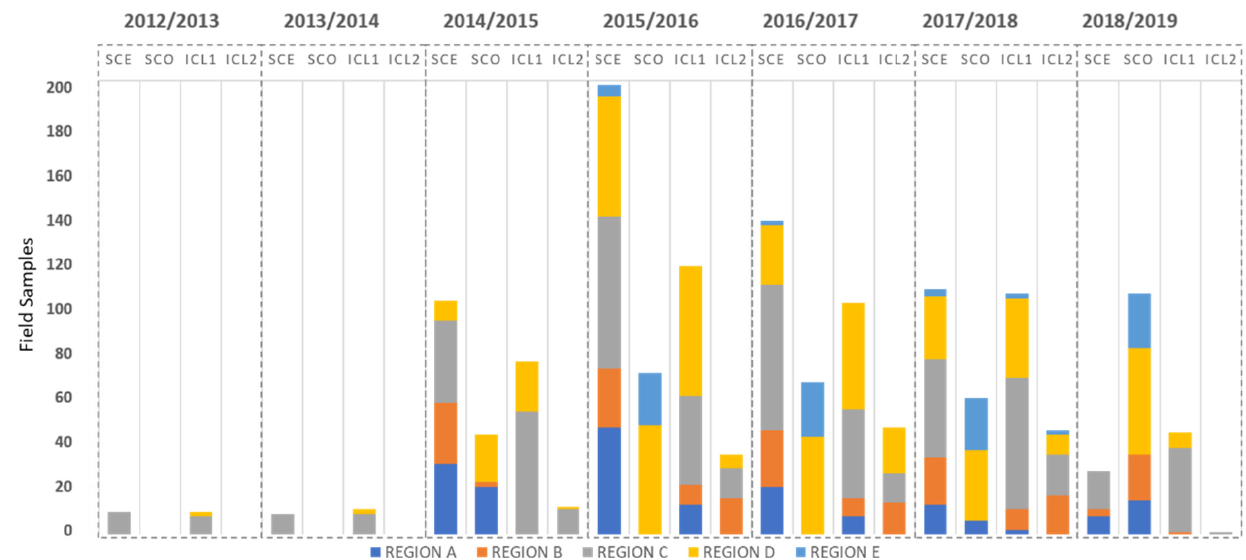
Figure 3. Spatio-temporal distribution of field samples by the four main classes according to each crop year and agro-climatic